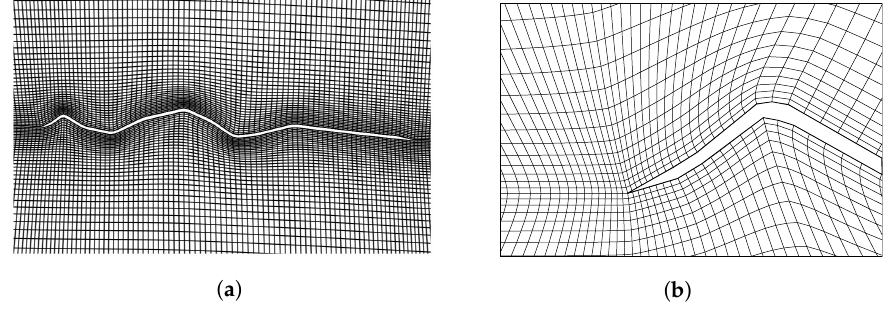
Figure 6. Computational grid: ( a ) corrugated airfoil; and ( b ) around leading edge.